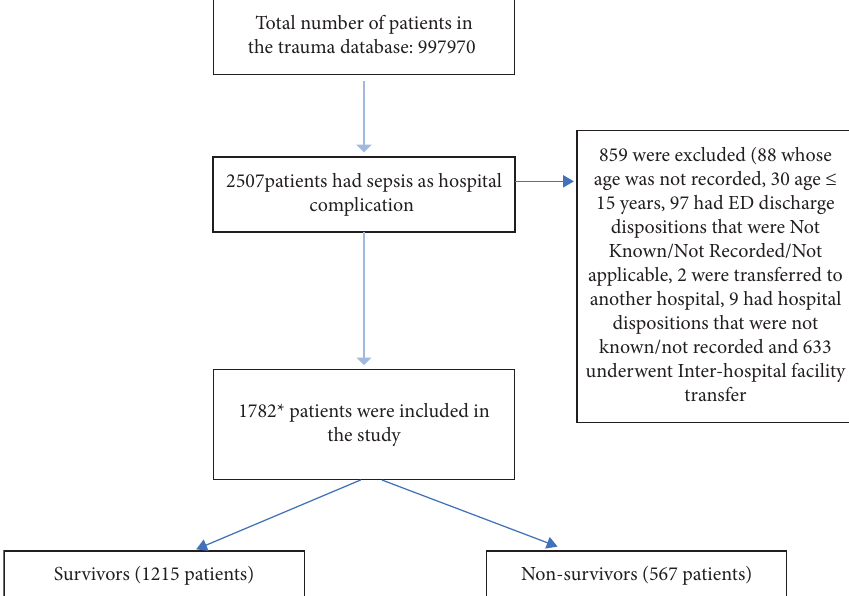
Figure 1: Flow diagram showing the inclusion and exclusion criteria of this study in addition to the total number of patients included in the analysis. ∗ Note: Tere are overlaps among the categories of the excluded variables. More specifcally, some patients who had interhospital facility transfer had an ED disposition as one of the excluded categories. Also, some patients whose age was not recorded or were 15years or younger were transferred or had an ED disposition as one of the excluded categories. Tese overlaps explain why the fnal number on which the data analysis was conducted cannot be calculated just by subtracting the number of excluded patients from the selected sample.